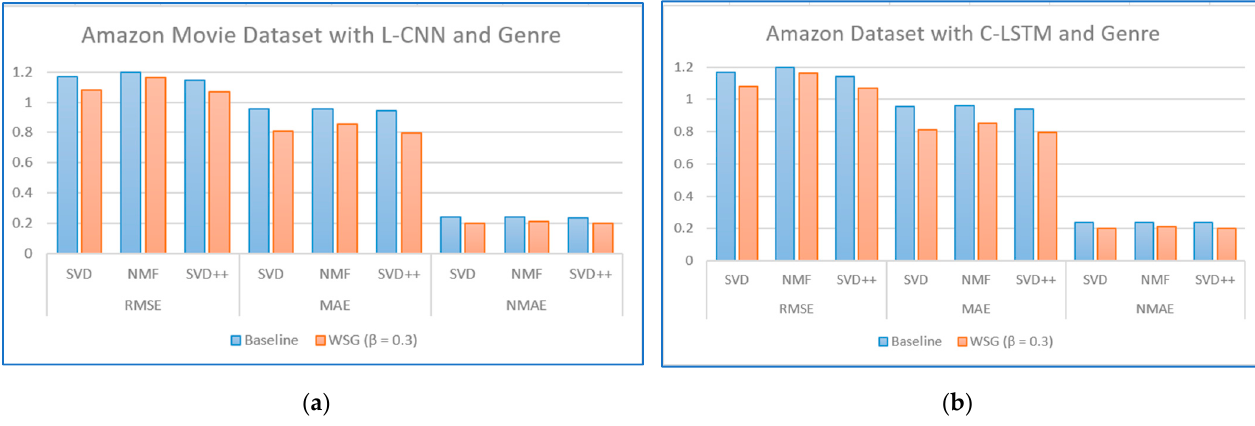
Figure 12. Comparison of the sentiment and genres-based model applied with 𝛽 = 0.7 against baseline on MARD dataset: